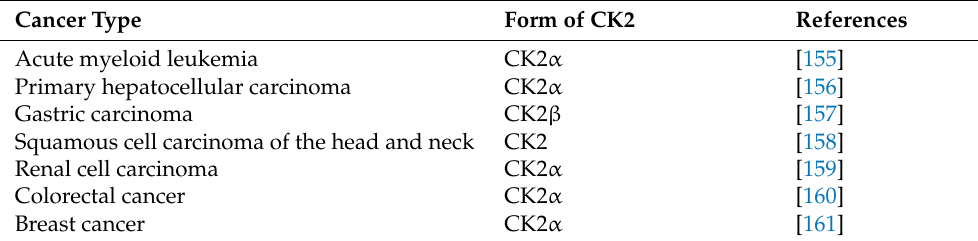
Table 2. CK2-subunit overexpression is a prognostic marker for several types of tumors. Cancer Type Form of CK2